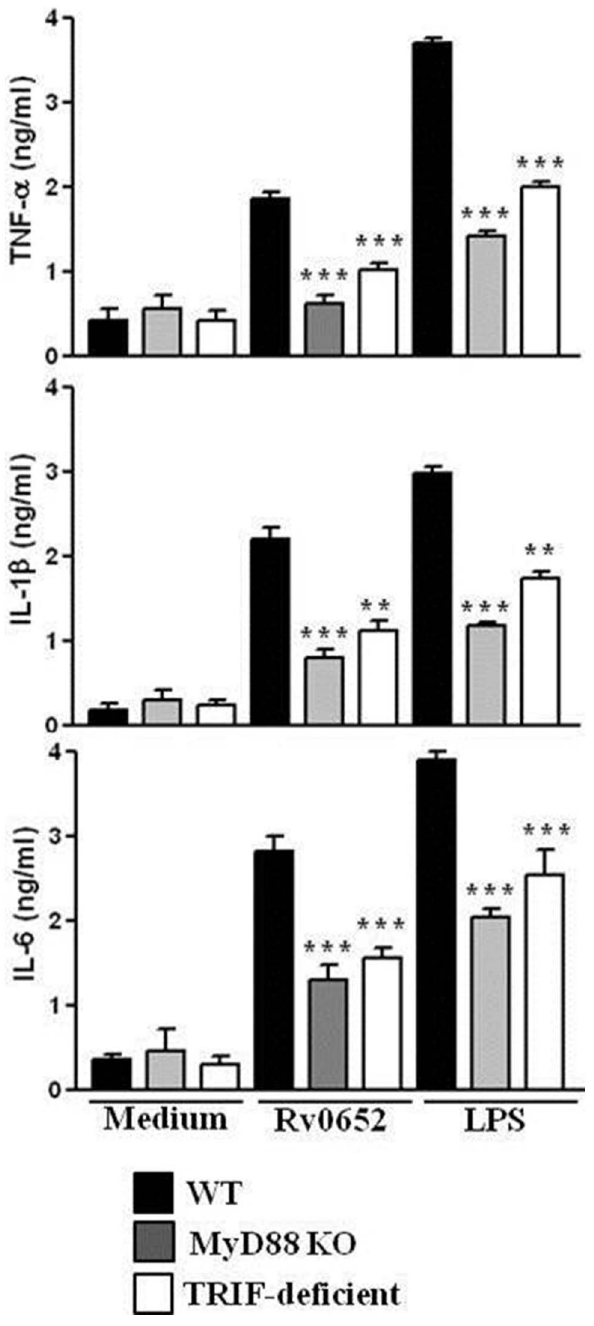
Figure 3. Rv0652-induced cytokine production is partially mediated by MyD88- and TRIF-pathways. DCs derived from WT, MyD88 2 / 2 , and TRIF-deficient mice were treated with Rv0652 (1 ug/ml) or LPS (200 ng/ml) for 24 h. The supernatants were harvested and ELISA was performed to test TNF-alpha, IL-6, and IL-1beta production. Data are means and SEM of 3 experiments. ** P , 0.01 and *** P , 0.001, compared to WT cultures.